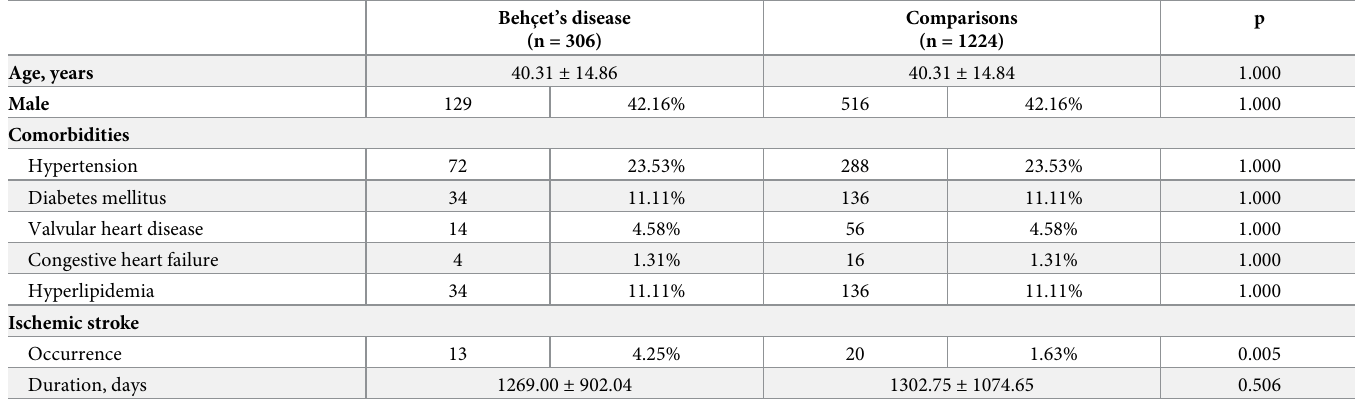
Table 1. Comparison of baseline characteristics between subjects with and without BD.